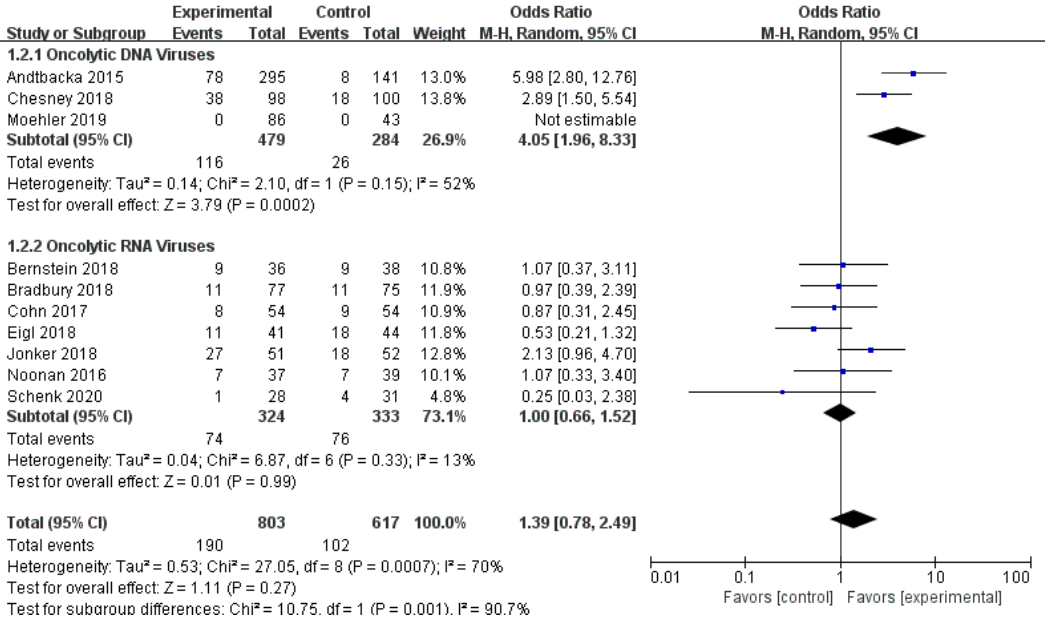
Figure 4. Forest plot of the pooled odds ratios (ORs) for objective response rate (ORR) of oncolytic DNA viruses and oncolytic RNA viruses.